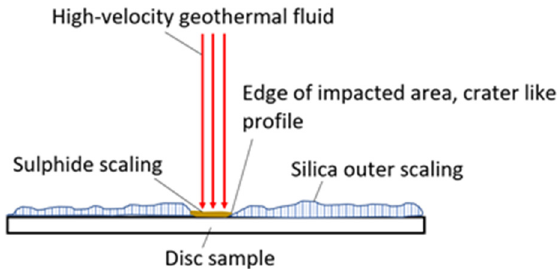
Figure 13. The most common scaling (inner sulfide and outer silica scaling) profile on samples after exposure in erosion testing.